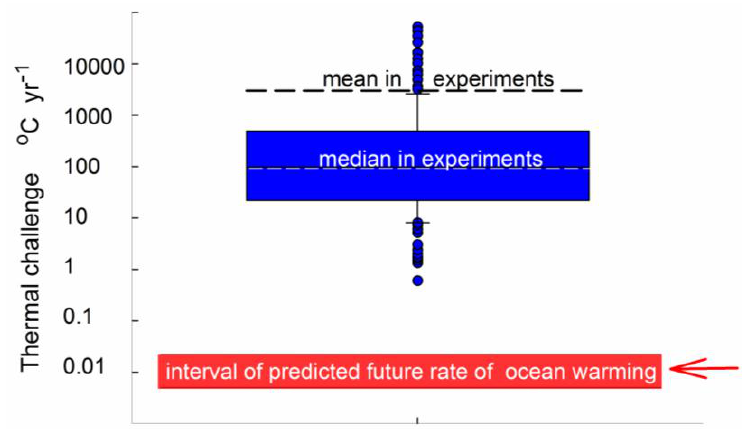
Figure 5. Thermal challenge severity in experimental studies of climate change impact on biodiversity in marine and freshwater environments in relation to reconstructions of past land and ocean global warming and prognosticated future global ocean warming. Thermal challenge severity (in °C × year −1 ) was calculated as the ratio of the magnitude of the difference in temperature between treatments (for studies with fixed treatments) or change in temperature over time (for studies with a gradually changing temperature treatment) and study duration in years. The hatched line above the box indicates the mean, the solid line within the box indicates the median, the boundaries of the box indicate 25th and 75th percentiles, whiskers below and above indicate 10th and 90th percentiles, and dots indicate outlying observations among the experimental studies. Box plot is based on data for 194 experimental studies. The red arrow to the right indicates the rate of past climate change, estimated from the globally averaged combined land and ocean surface temperature data as calculated by a linear trend, show a warming of 0.85 (0.65 to 1.06) °C, over the period 1880 to 2012 [1]. The red box indicates the upper and lower bound of the rate of future global ocean warming, as calculated based on best estimates of ocean warming in the top one hundred meters of about 0.6 °C to 2.0 °C by the end of the 21st century [1]. Estimated future ocean warming is lower, about 0.3 °C to 0.6 °C, at a depth of about 1000 m [1].